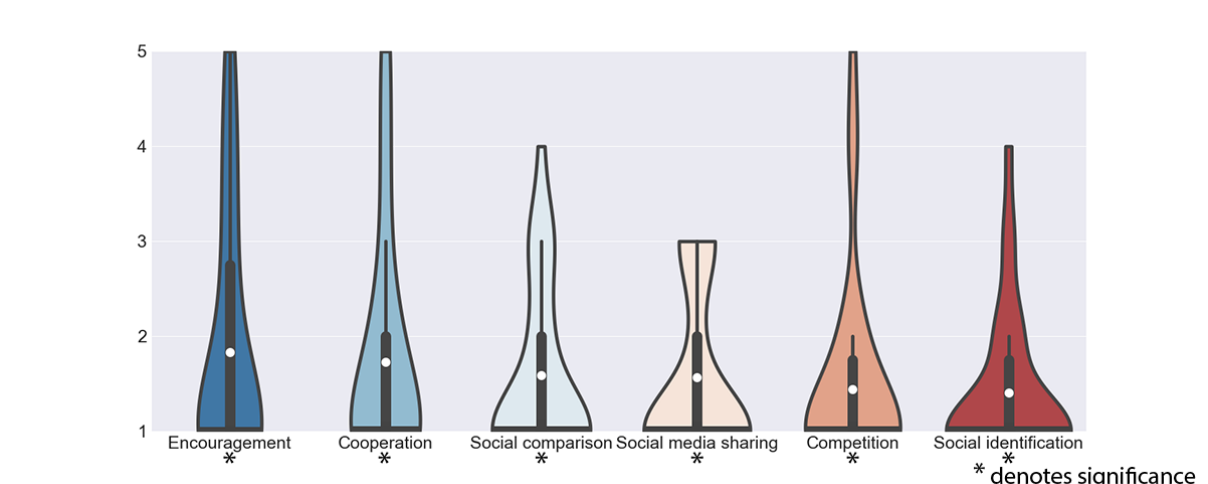
Social media sharing (μ